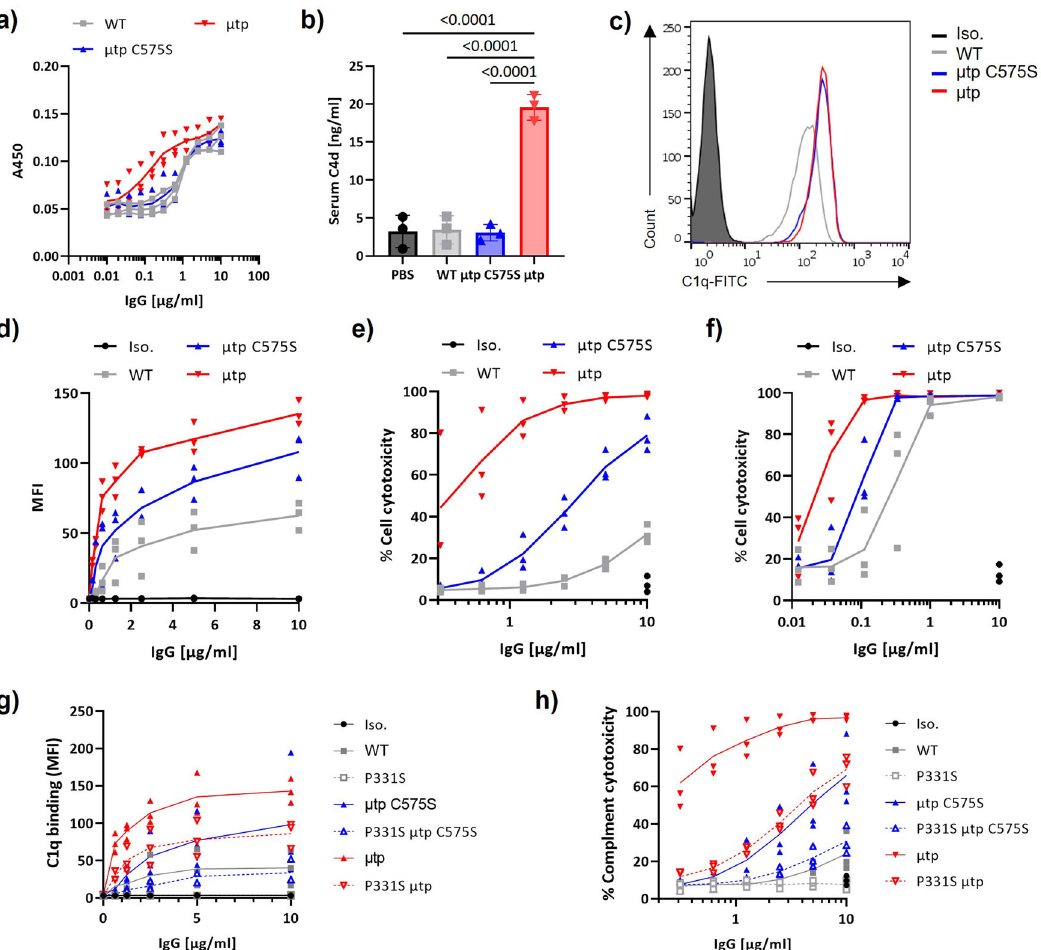
Fig. 3 CDC enhancement of hIgG1 μ tp C575S and μ tp pre-formed hexamer. a ELISA plates were coated with rituximab hIgG1 μ tp constructs at various concentrations and puri fi ed human C1q (2 μ g/ml) added. Bound C1q was detected with a goat-anti-C1q, followed by an anti-goat-HRP-conjugated antibody. Data show absorbance at 450 nm ( n = 3). b Fluid-phase C4d was measured in human serum after 1 h incubation with various rituximab hIgG1 constructs at 100 μ g/ml. Data show C4d concentration of individual donors ( n = 3). c Ramos cells were opsonised with rituximab hIgG1 constructs at 10 μ g/ml,